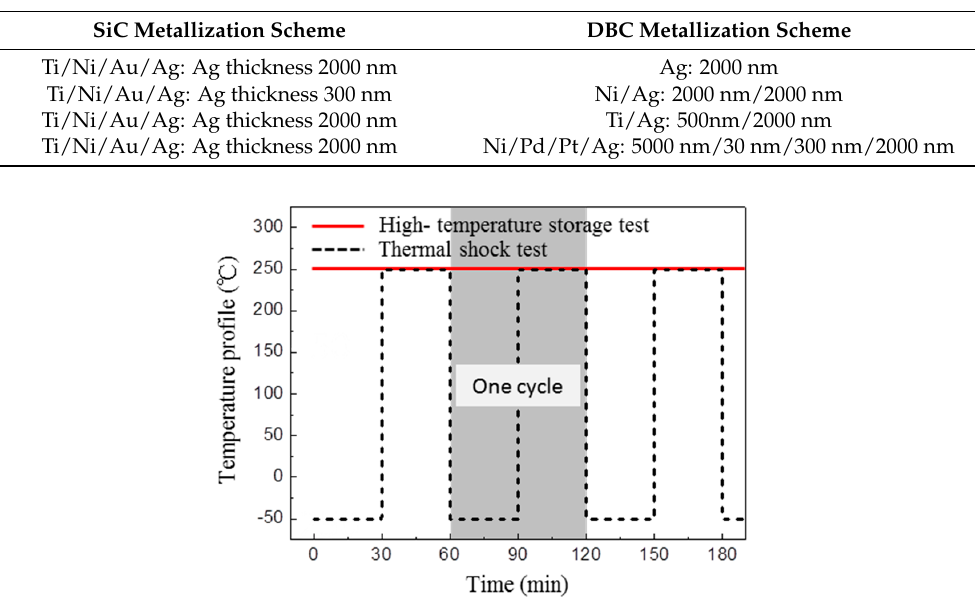
Figure 1. Diagrams of ( a ) SiC- direct bonded copper (DBC) joint, and ( b ) pressure-aided sintering. Table 2. Specifications of direct bonded copper (DBC) substrates and SiC chips.